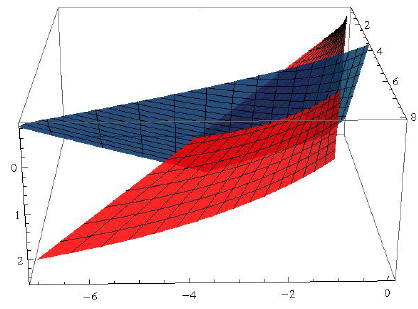
Figure 8. The red (blue) surface is the null scroll with generalized T ( B ) -lightlike ruling X 1 ( X 2 )